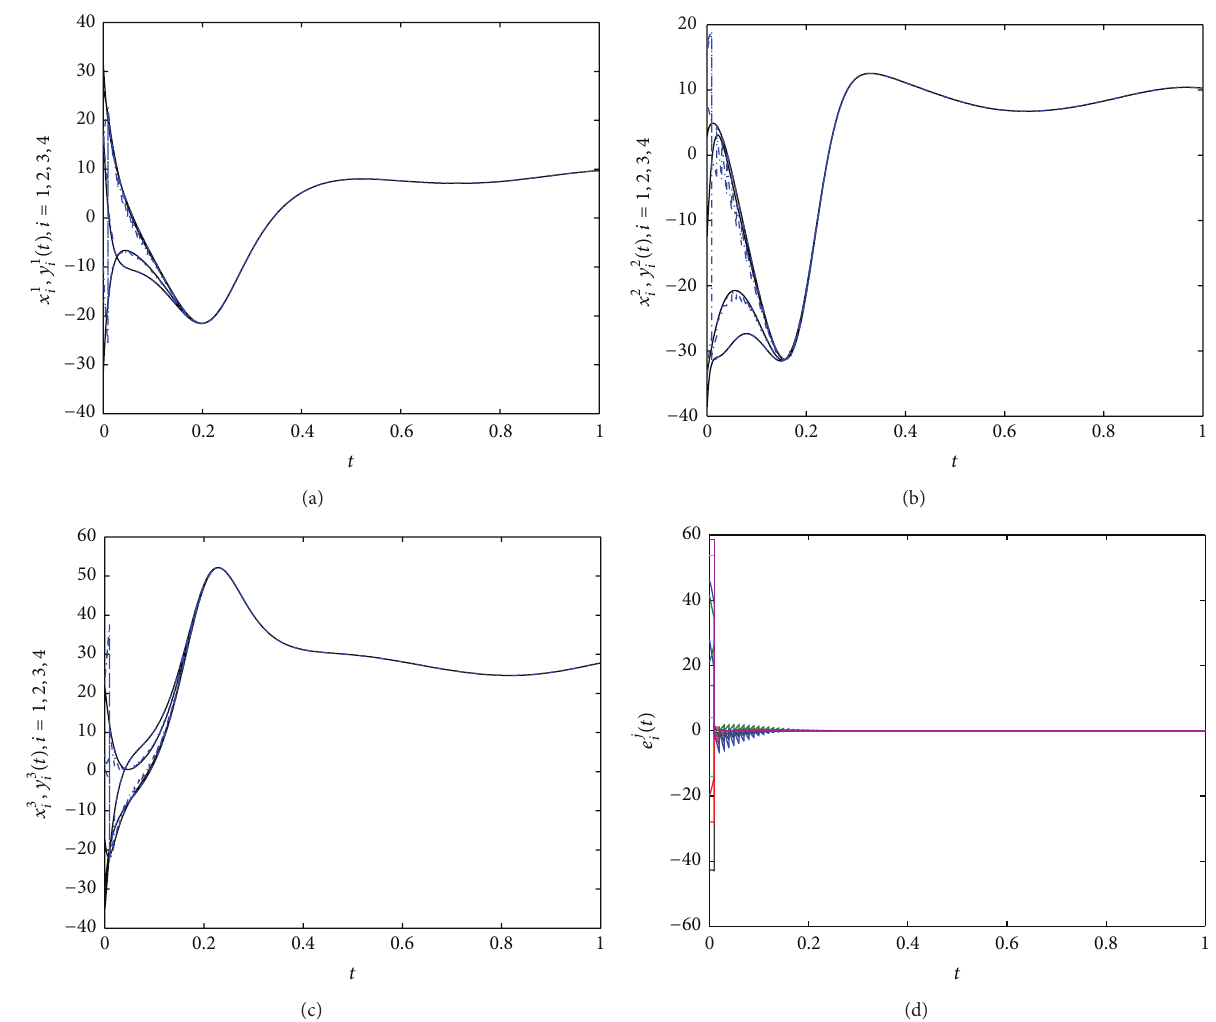
Figure 3: Time evolution between node 𝑥 𝑘 𝑖 and node 𝑦 𝑘 𝑖 , 𝑖 = 1, 2, 3,4 , 𝑘 = 1,2, 3 , and error evolution between drive and response networks under impulsive